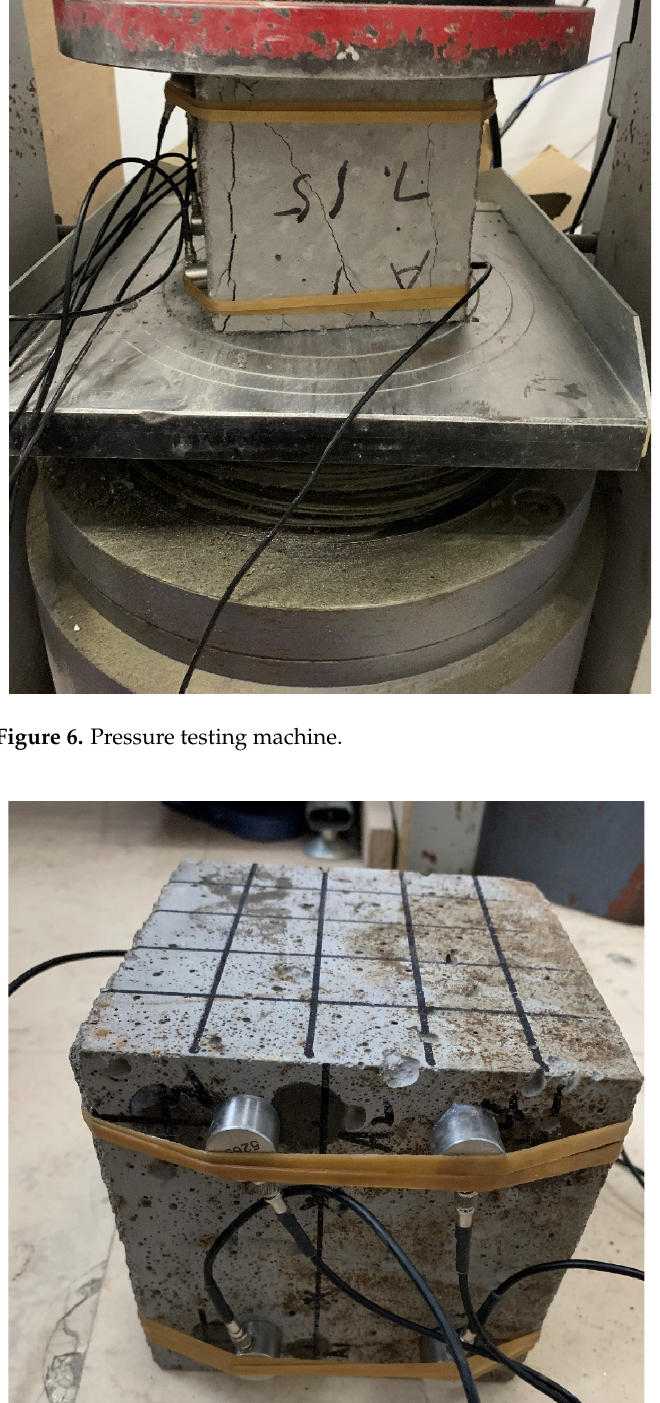
Figure 7. Sensor layout